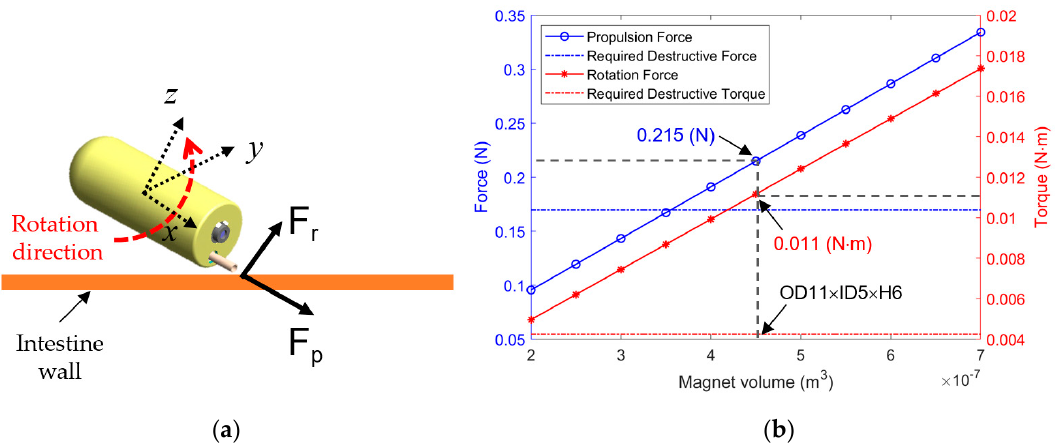
Figure 5. ( a ) Biopsy procedure and cutting force. ( b ) Estimation of the propulsion force and rotation torque based on the simulated volume variation of the PM#1.